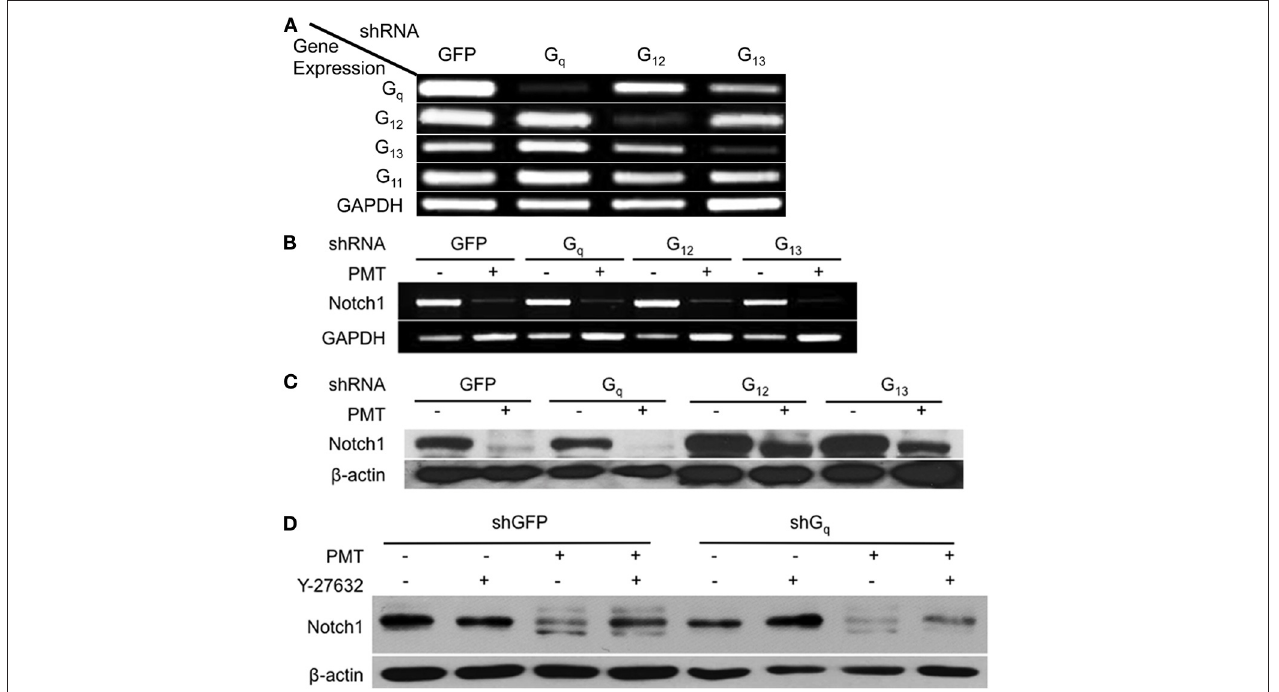
FIGURE 5 | Involvement of G α q and G α 12 / 13 -dependent Rho/ROCK signaling in Notch1 downregulation by PMT in 3T3-L1 cells. (A) 3T3-L1 preadipocytes were infected with viral particles encoding shRNA against G α q , G α 12 , G α 13 , or GFP (as control) and selected with puromycin for 1 week. Cell lysates were analyzed for mRNA levels for G α q , G α 11 , G α 12 , G α 13 , or GAPDH (as control) by RT-PCR. (B) Notch1 mRNA expression levels in 3T3-L1 cells expressing shRNA against G α q , G α 12 , G α 13 , or GFP and then treated without (control) or with 0.5nM PMT for 16h and analyzed as in (A) . (C) Notch1